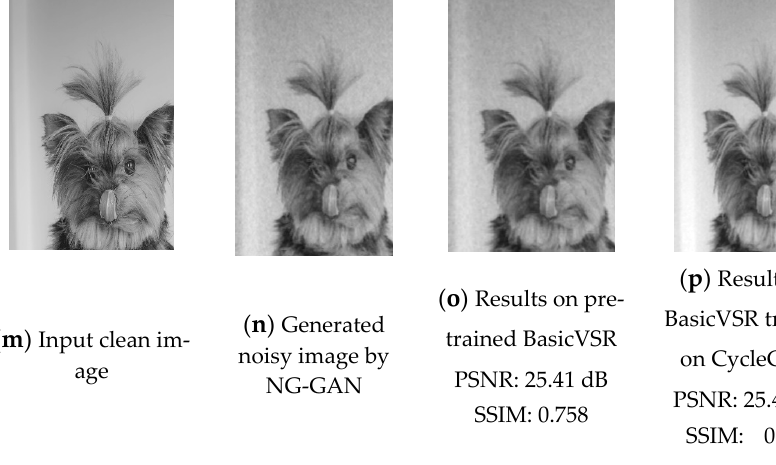
Figure 8. Examples of oldifying and de-oldifying videos using pre-trained SOTA methods, SOTA methods trained on C2N and NG-GAN generated dataset. ( a , g , m ) High quality images form Flickr 2 k image dataset. ( b , h , n ) Oldified noisy frames generated by NG-GAN. ( c , i , o ) De-oldification output from pre-trained BasicVSR. ( d , j , p ) De-oldification output from BasicVSR++ trained on CycleGAN generated dataset. ( e , k , q ) De-oldification output from BasicVSR++ trained on C2N generated dataset. ( f , l , r ) De-oldification output from BasicVSR++ trained on NG-GAN generated dataset. Table 1. Comparison of old noisy images denoised by state ‐ of ‐ the ‐ art denoisers and image restorers trained on the dataset generated by our proposed model.